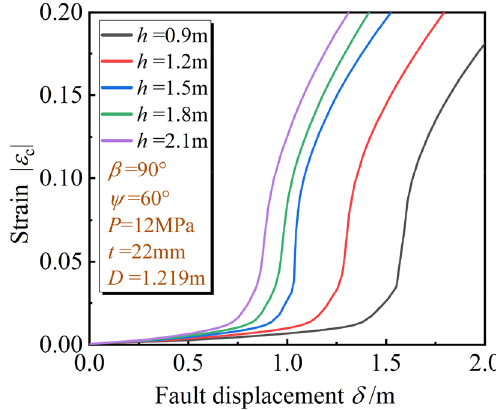
Figure 19. Variation of ε c with δ under different h.